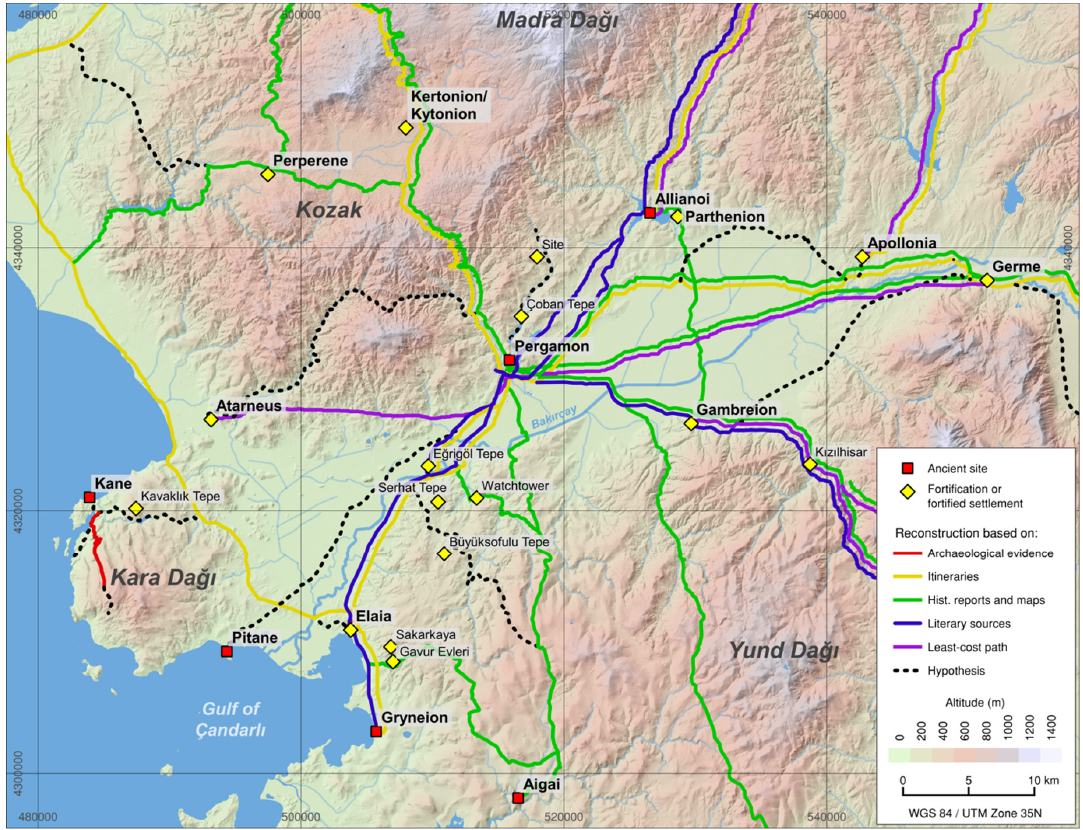
Figure 30. Reconstructed route network in the surroundings of Pergamon. The yellow squares represent fortifications or fortified settlements.